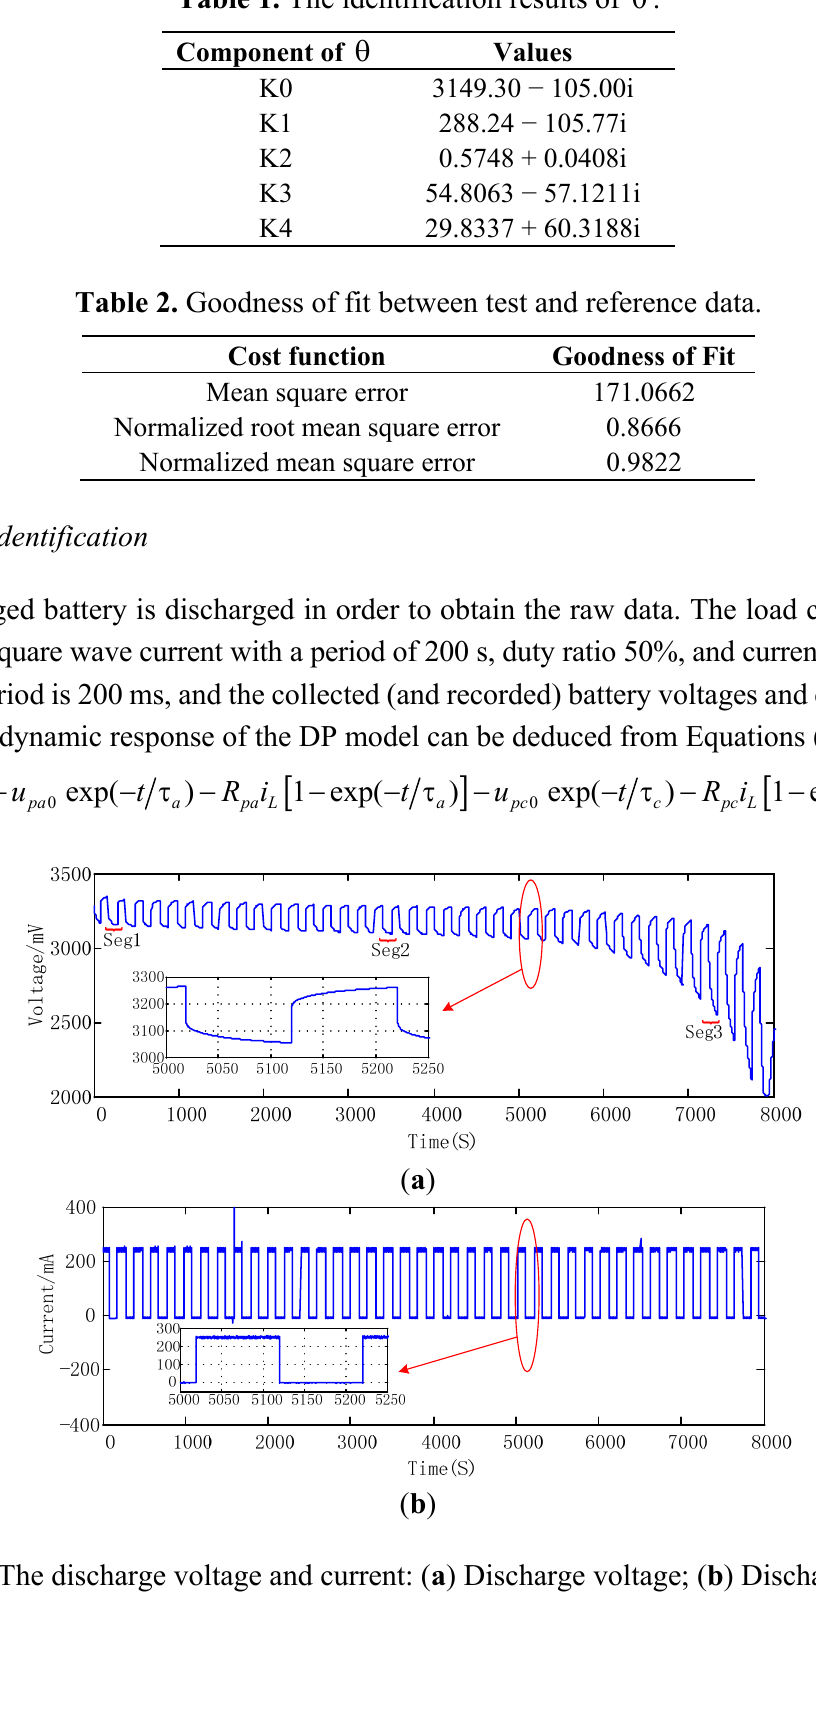
Table 1. The identification results of  .